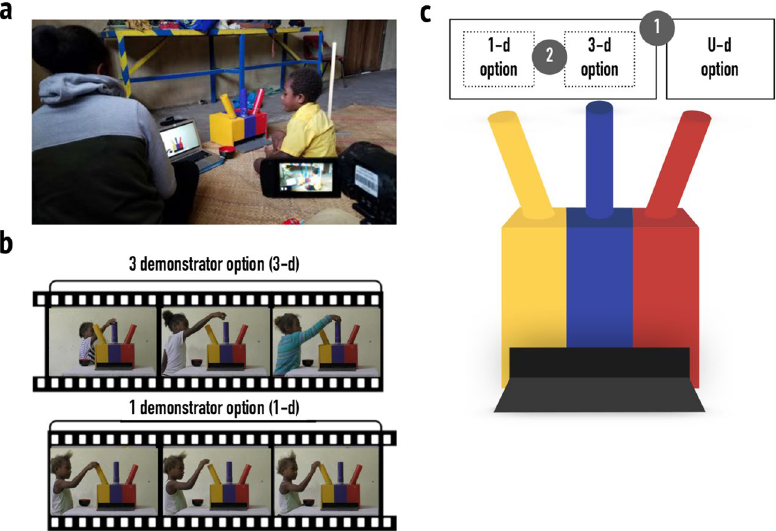
Figure 1. Study Design and Setup. Panel ( a ) shows the study setup (photo by Jule Wolf), panel ( b ) shows an example demonstration video, and panel ( c ) shows the possible response options (1-d option, 3-d option, U-d option), in this counterbalancing version in the colors yellow, blue and red, respectively. On the level of observed responses, we describe (1) children’s tendency to respond following the demonstrated options by comparing the proportion of children who chose one of the two demonstrated options with those who chose the undemonstrated option (solid lines), and (2) children’s “3-demonstrator” responses by comparing the proportion of children who chose the 3-d option with those who chose the 1-d option (dotted